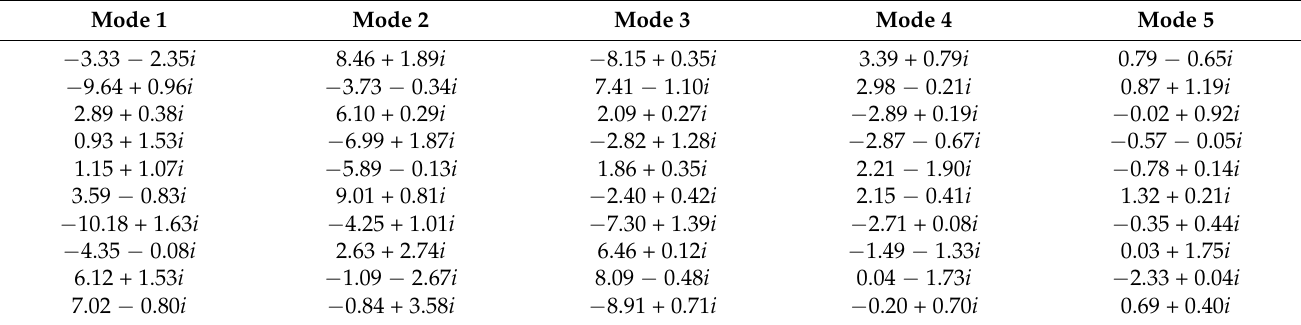
Table A6. Mode shape vector of UCBC #5 specimen. ( i : imaginary